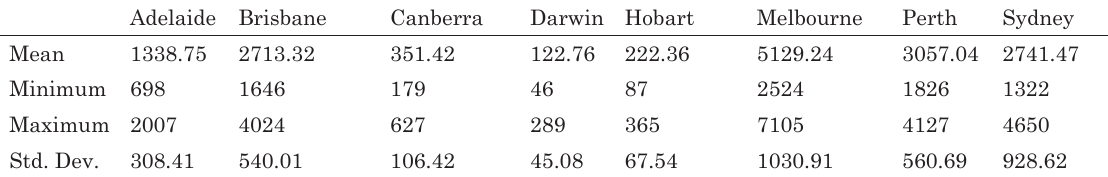
Table 2. Statistics of the approved numbers of new houses in Australian capital cities